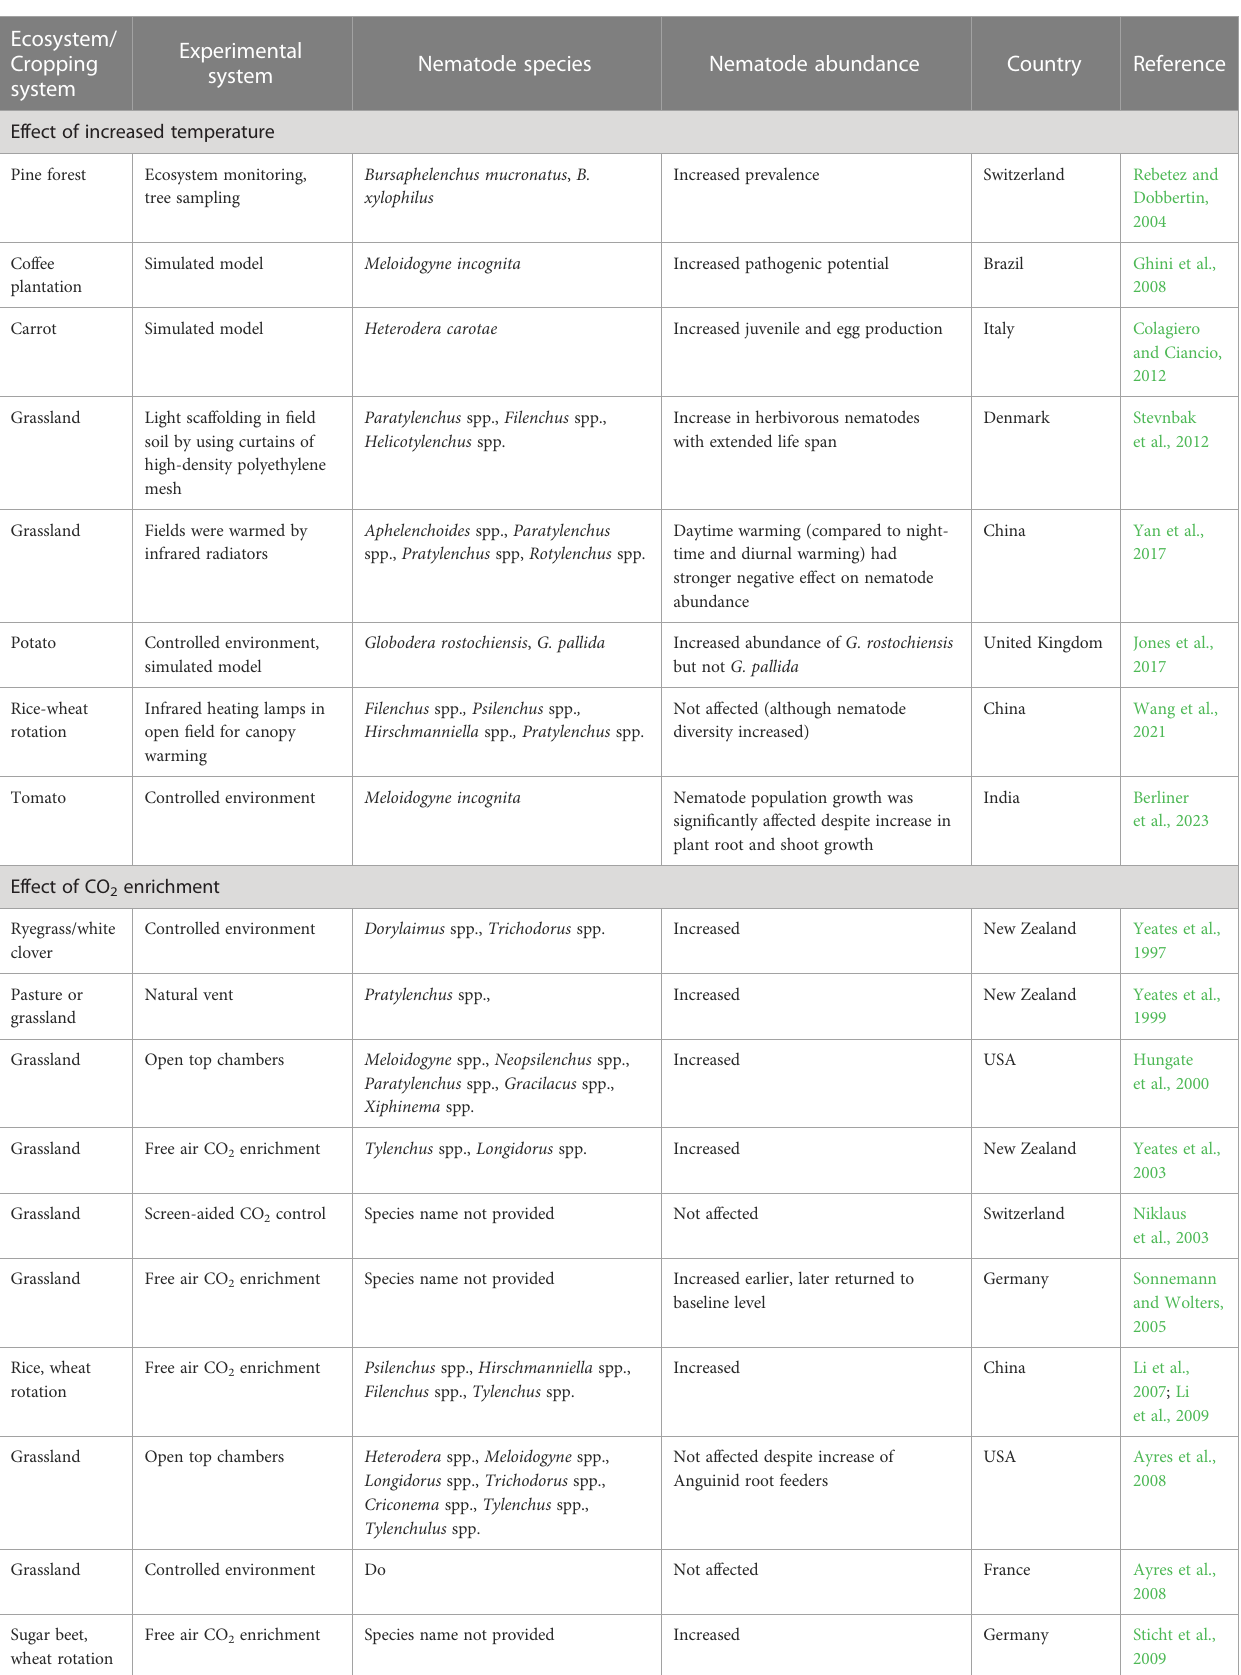
TABLE 1 Variable response of plant-parasitic nematodes to altered temperature, CO 2 and precipitation